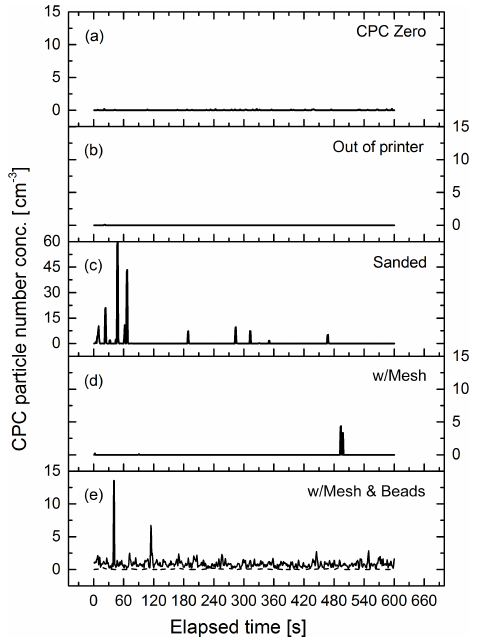
Figure 5. Average particle size distributions: (a) OPS with filter; (b) freshly printed generator; (c) through the generator after wet sanding; (d) through the generator after wet sanding and installing the porous screen; (e) fully assembled generator including porous screen and bronze beads atop as bed material, without (circles) and with a stainless steel insert